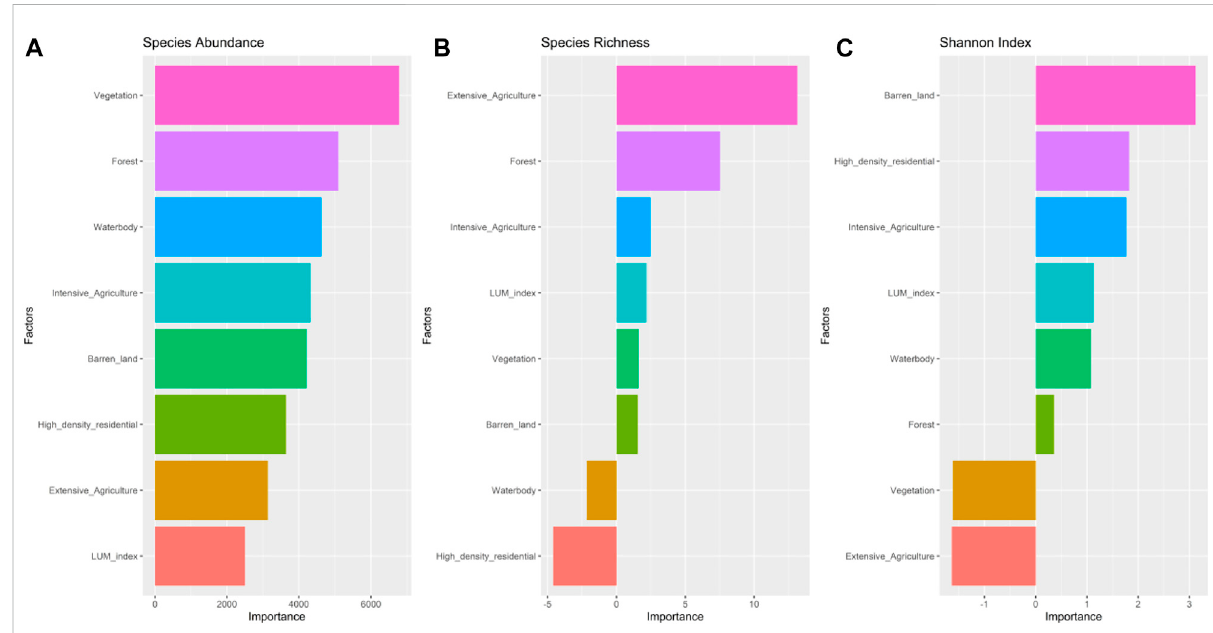
FIGURE 7 Weight of different landscape factors predicting species abundance (A) , species richness (B) , and Shanon index (C) . Weight of each factor contributing most to predicting the species diversity was analyzed using a neural network